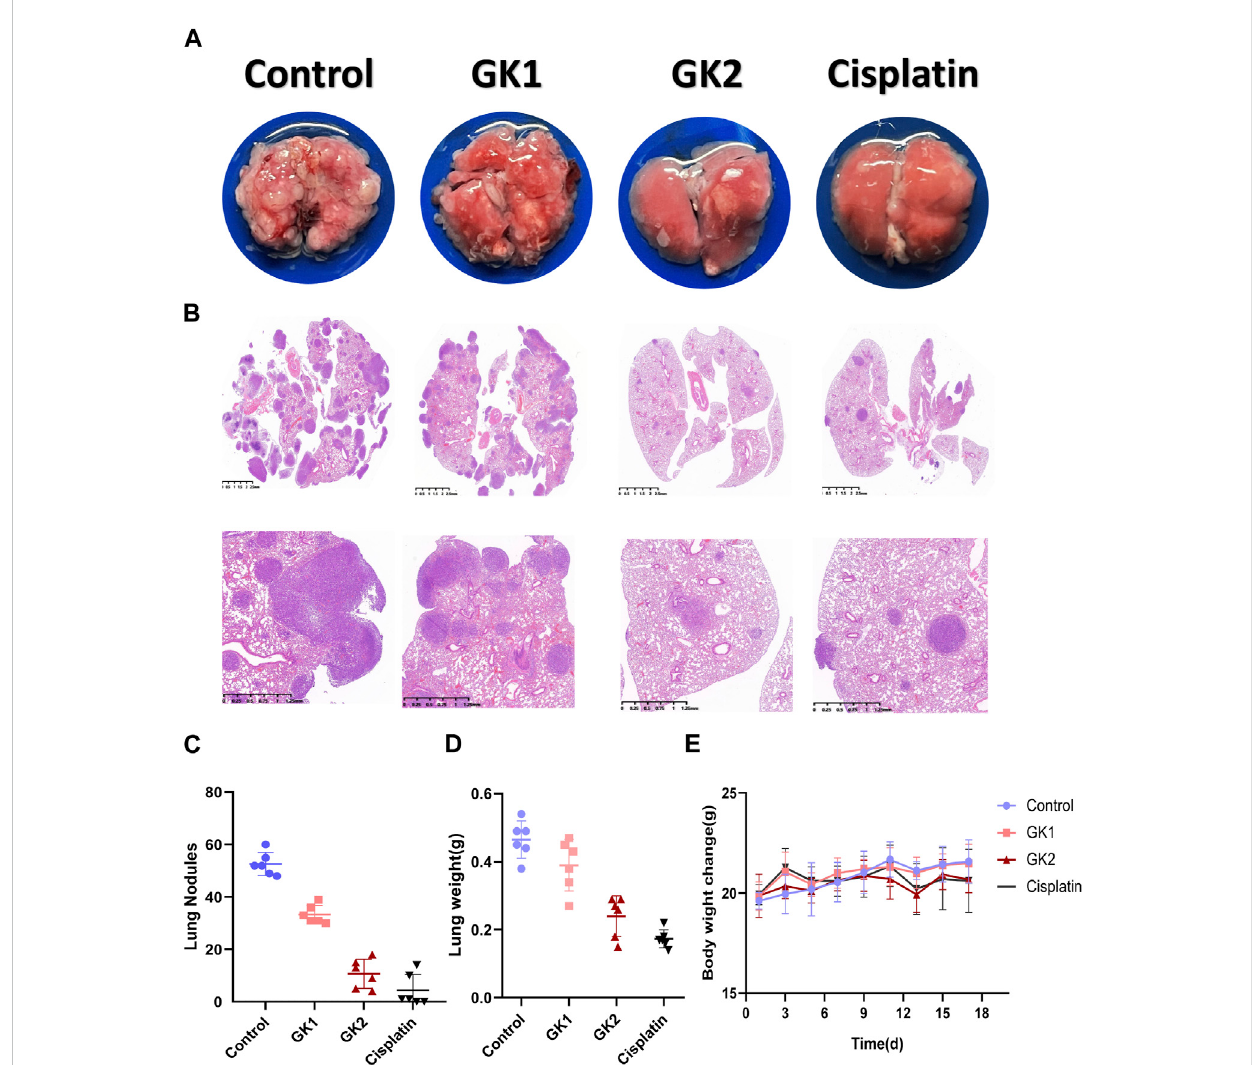
FIGURE 11 GK and Cisplatin suppresses the growth of lung metastases. (A) . 1.5×10 5 LLC cells were injected into the tail vein of mice to establish a lung metastasesmodel; n =6micepergroup.Thetreatmentstartedthedayaftertheinjection.Miceweresacri fi ced14daysafterinjection. (B) .Representative lungs and HE staining ( n = 6). (C) . Count of lung nodules in each group ( n = 6). (D) . Weight of mouse lung. (E) . Change in body weight of